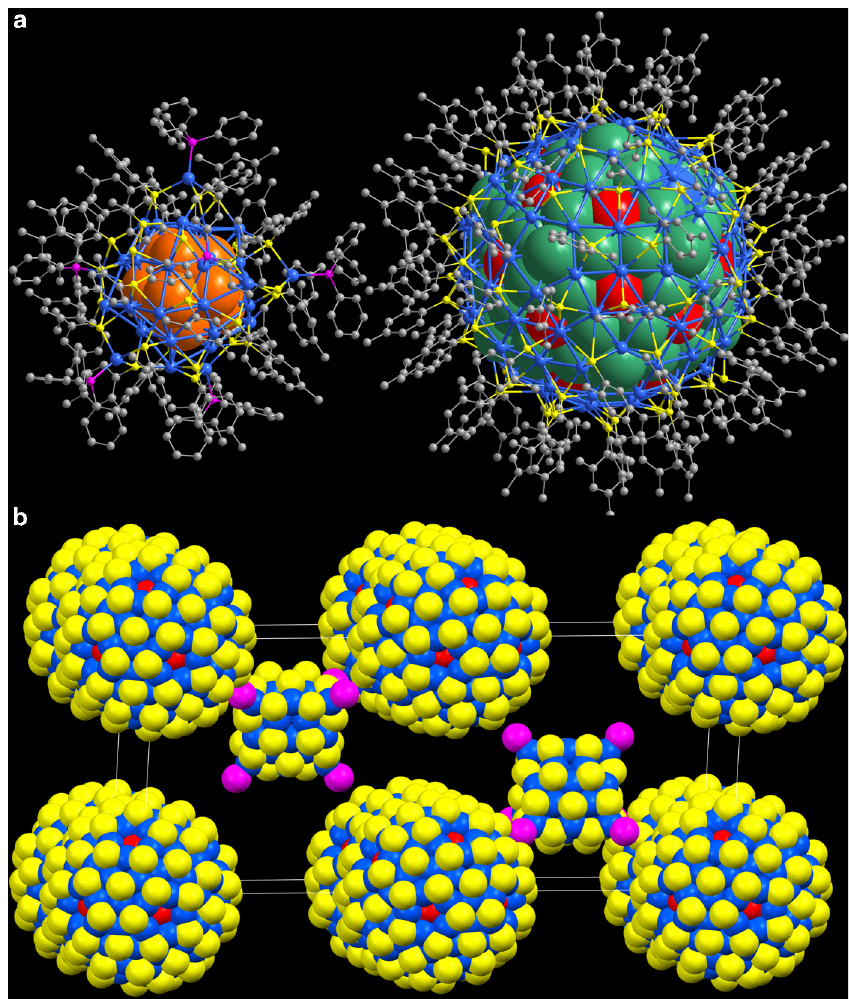
Fig. 1 Cocrystal structure of (AuAg) 267 ∙ (AuAg) 45 . a The total structure of the plasmonic (AuAg) 267 nanoparticle co-crystallized with the molecule-like (AuAg) 45 cluster. All hydrogen atoms are omitted for clarity. b Unit cell of the three-dimensional structure of spherical (AuAg) 267 nanoparticles and trigonal prismatic (AuAg) 45 nanoclusters in space- fi lling model. All hydrogen and carbon atoms are omitted for clarity. Color code: orange Au, sea green and red AuAg, blue Ag, yellow S, magenta P, gray